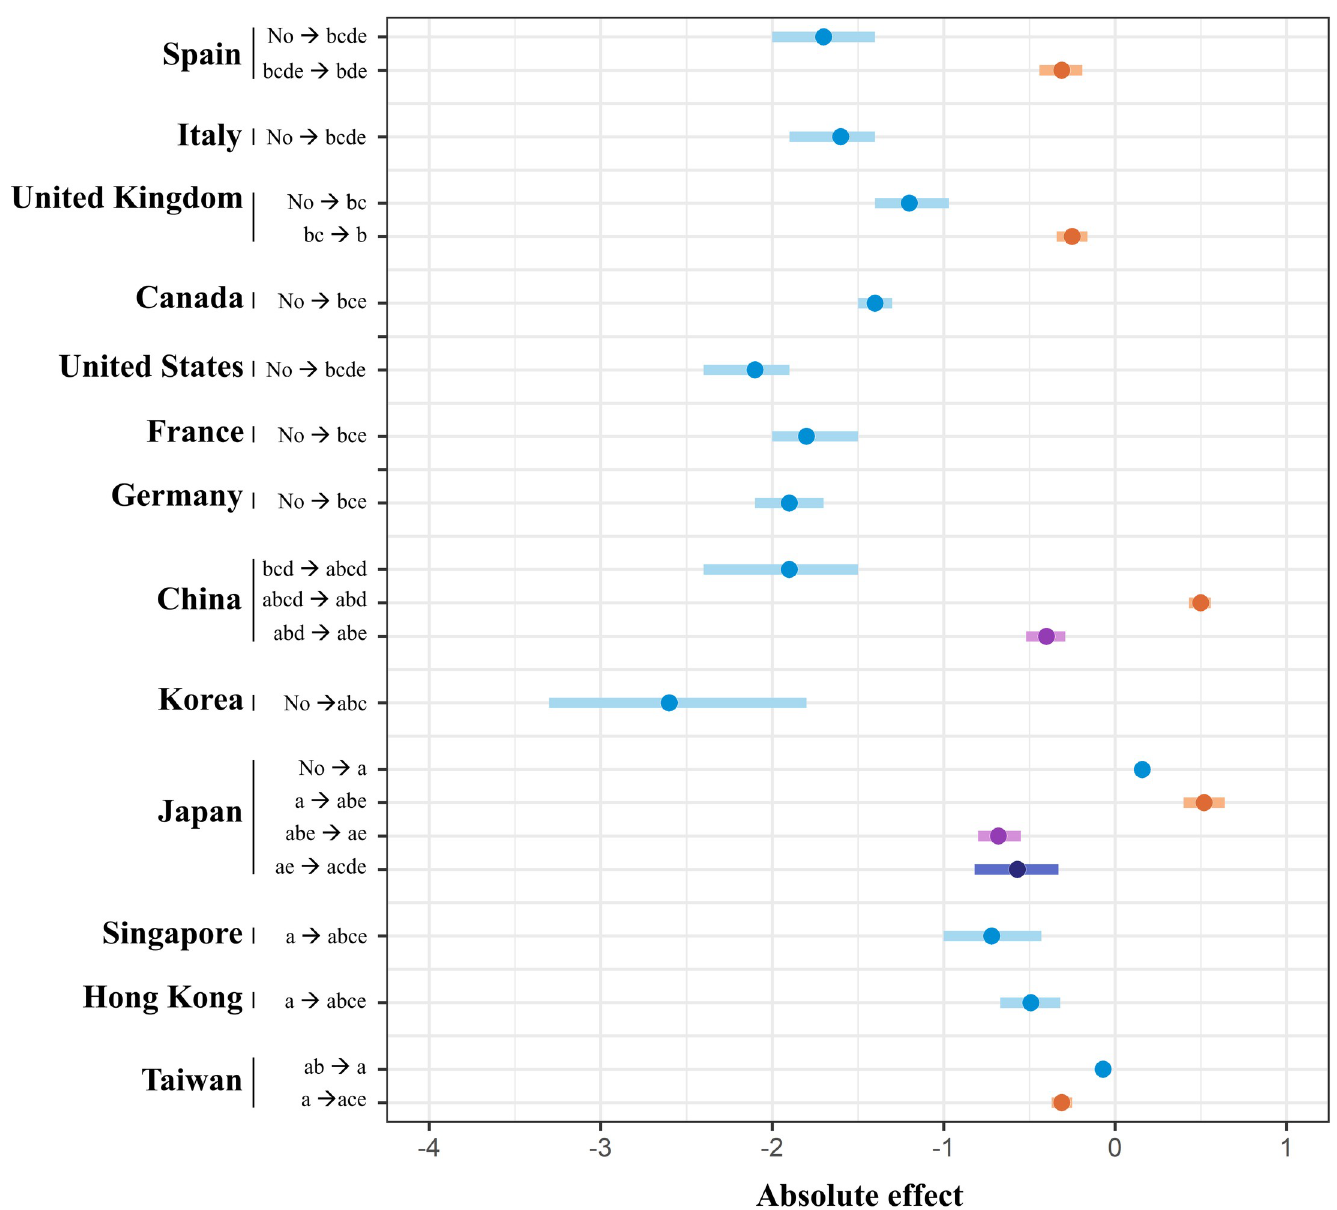
Fig 4. Absolute effect of government policies on reproduction